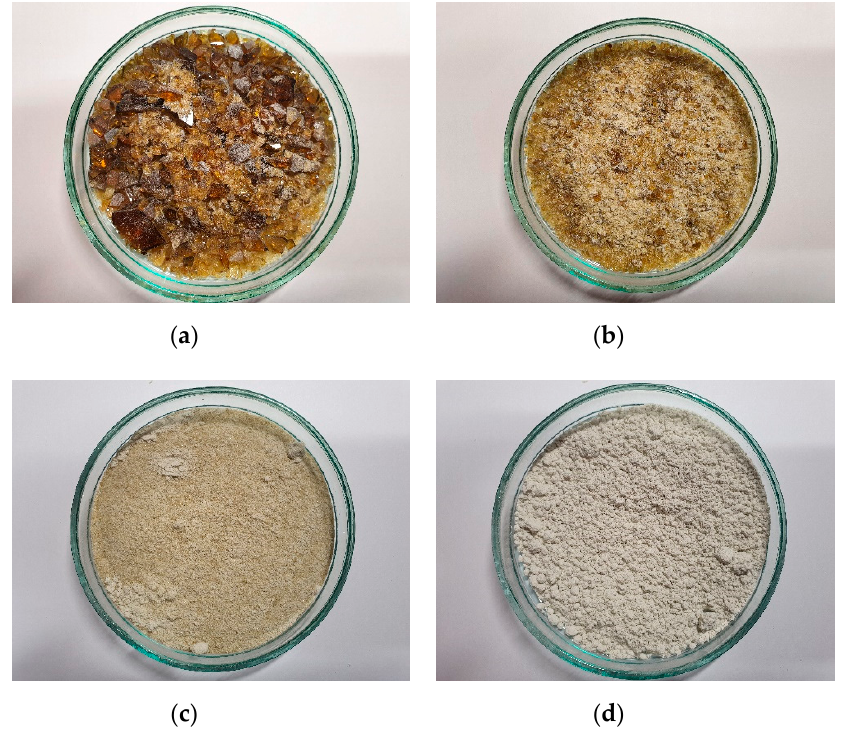
Figure 2. Crushing stages: ( a ) initially crushed; ( b ) crushed in crusher; ( c ) crushed in crusher and ground in mill; ( d ) crushed in crusher, ground in mill, and powdered in micro-Deval apparatus.